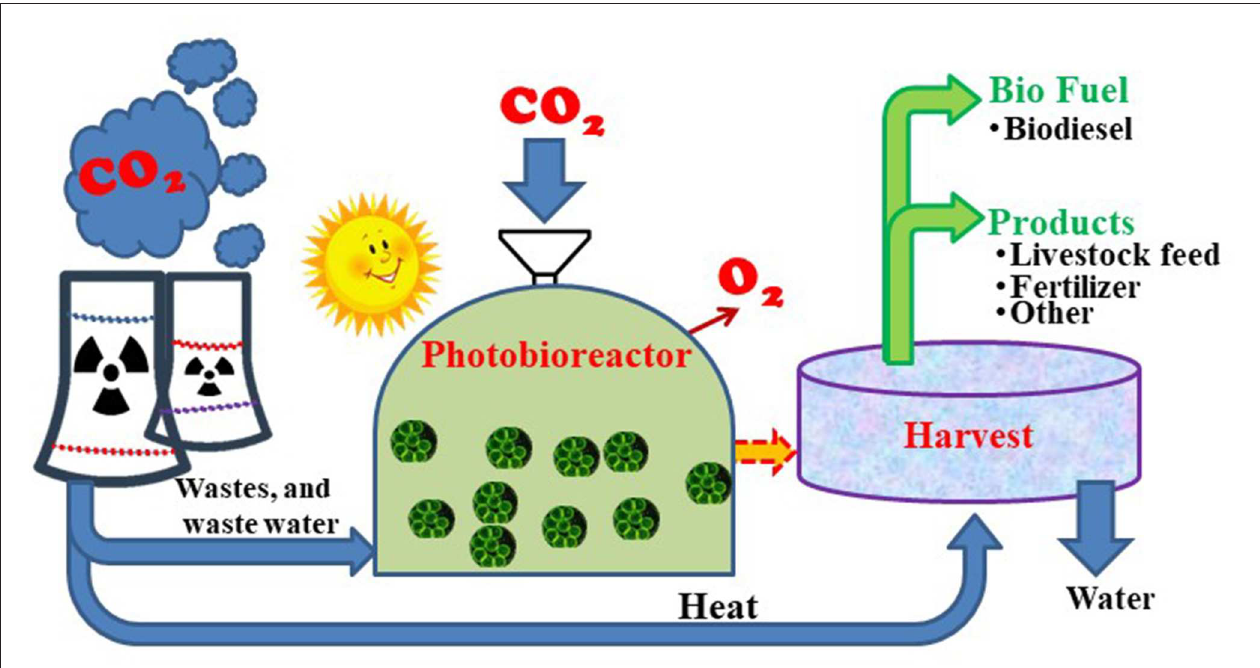
FIGURE 3 | Carbon dioxide capture by microalgae for biomass and value-added product